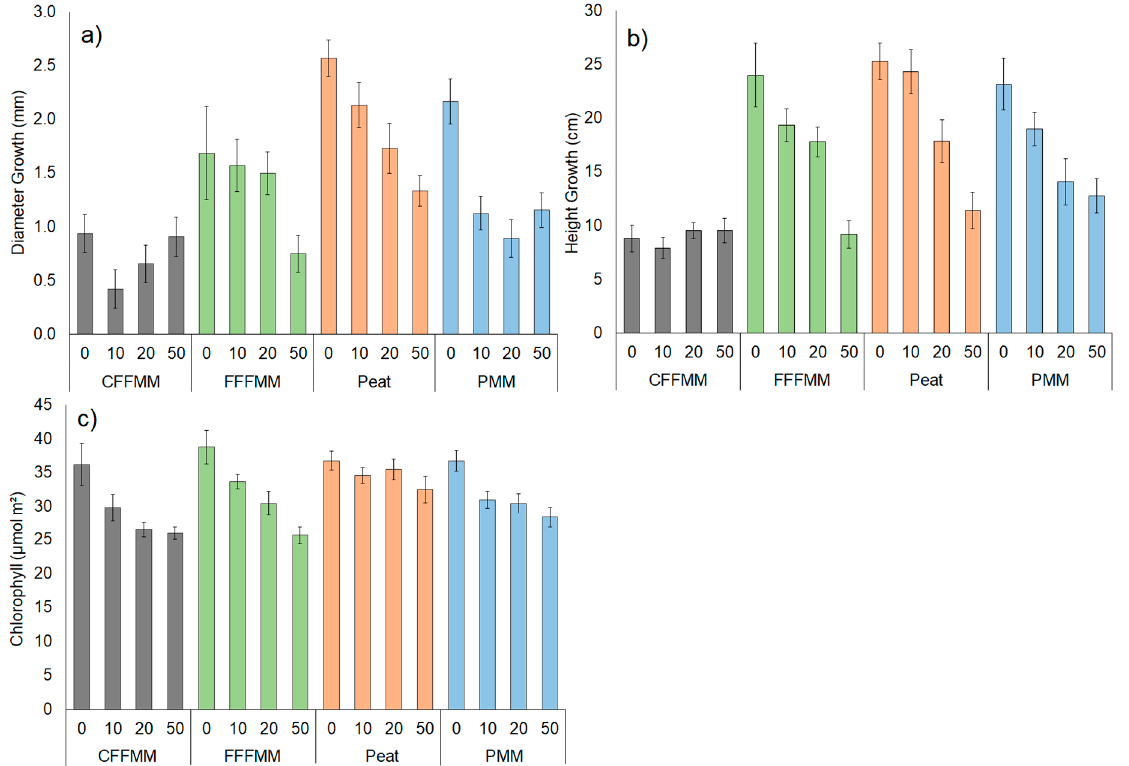
Figure 2. ( a ) Diameter growth (mm), ( b ) height growth (cm), ( c ) foliar chlorophyll concentration ( μ mol m 2 ), for each soil type and 0%, 10%, 20% and 50% wood amount. Values are averages with standard error. cFFMM (grey), coarse forest floor ‐ mineral mix; fFFMM (green), fine forest floor ‐ mineral mix; peat (orange); and PMM (blue), peat ‐ mineral mix.